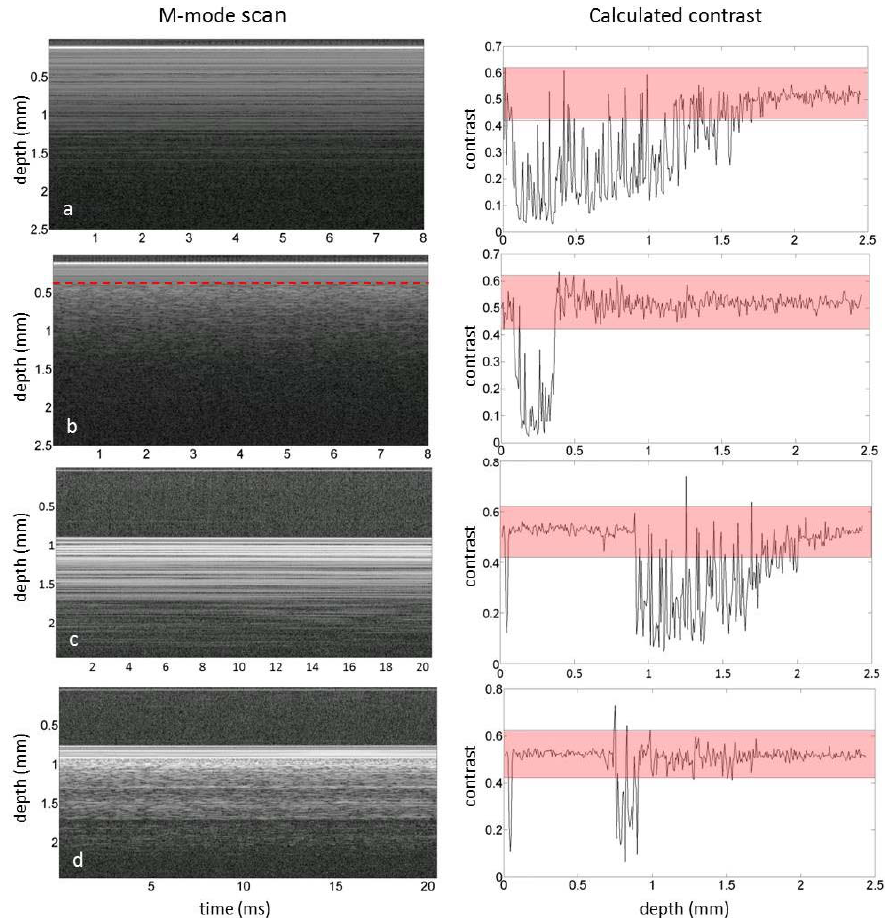
Figure 7. Single M ‐ mode OCT scans ( left ) and the corresponding calculated contrast ( right ) of a. a static region of the flow phantom, b. a region with flow in the flow phantom in which the red line depicts the approximated location of the top of the flow channel, c. a static region of tissue and d. a region with flow in tissue by a blood vessel at approximately 0.2 mm below the tissue surface. The red bar depicts the speckle contrast threshold used in this manuscript.